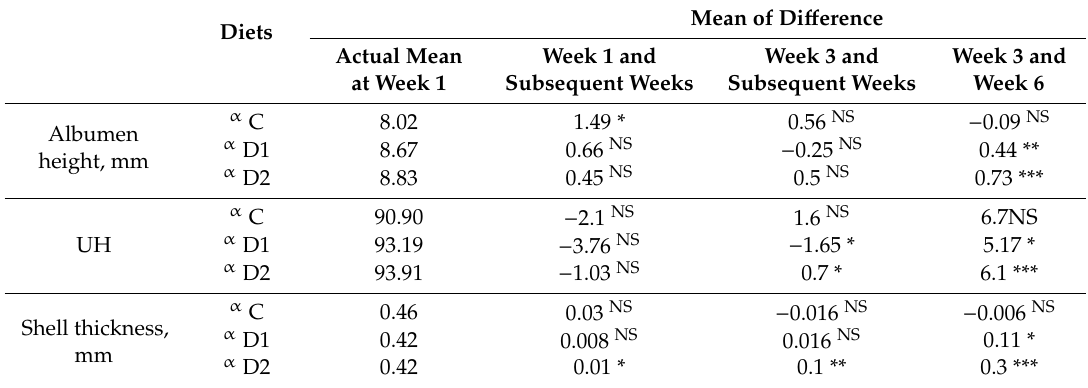
Table 4. Week e ff ect of the diet’s distribution on albumen height, UH (Haugh Unit), and shell thickness. Mean of Di ff erence Diets Actual Mean Week 1 at Week 1